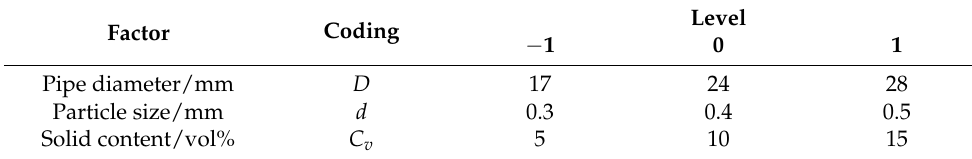
Table 3. Table of test factors and coding level.